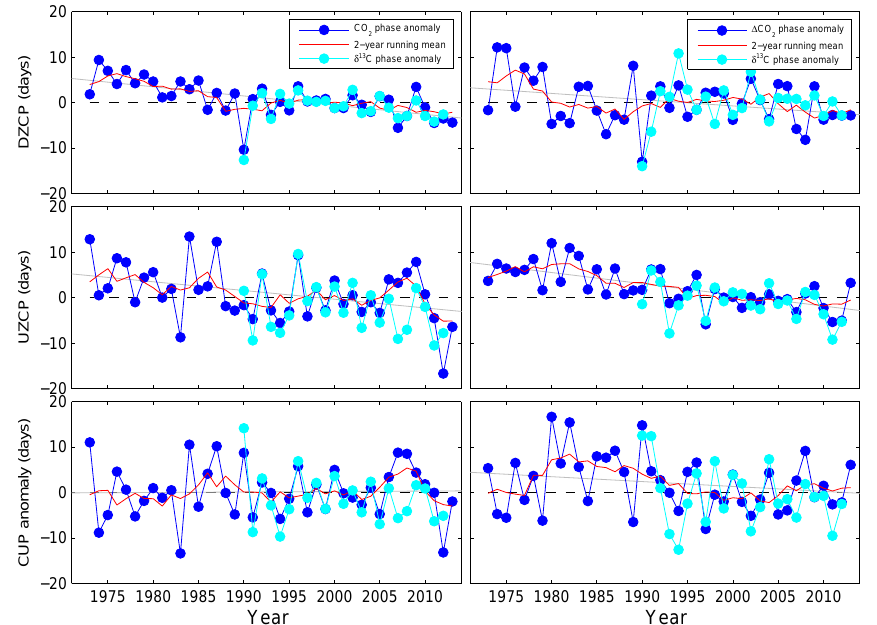
Figure 9. Time series of phase changes and the corresponding change to the carbon uptake period of δ 13 C and CO 2 (left) and (cid:49) t δ 13 C and (cid:49) t CO 2 (right), expressed as days. The red line is the 2-year running mean.